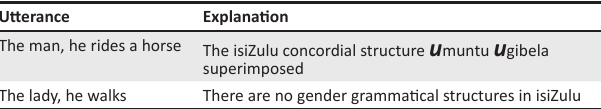
Reasons for adaptation